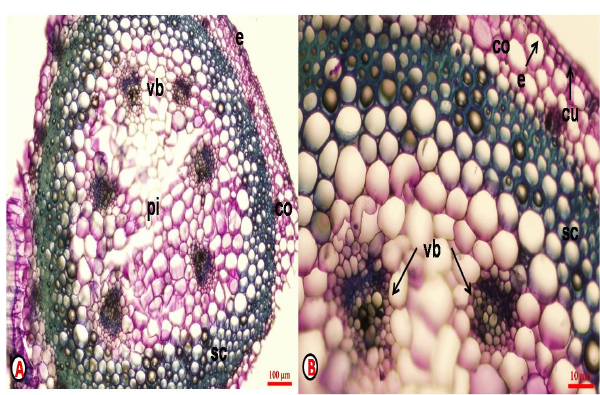
Fig. 3. Transversal section of Allium wallichii scape: A) Showing the entire structure of the Scape; B) A portion of the same, showing the two vascular bundles and the peripheral part of the scape; cu - cuticle layer; co - cortex; e - epidermis; sc - sclerenchyma; pi - pith; vb - vascular bundle.